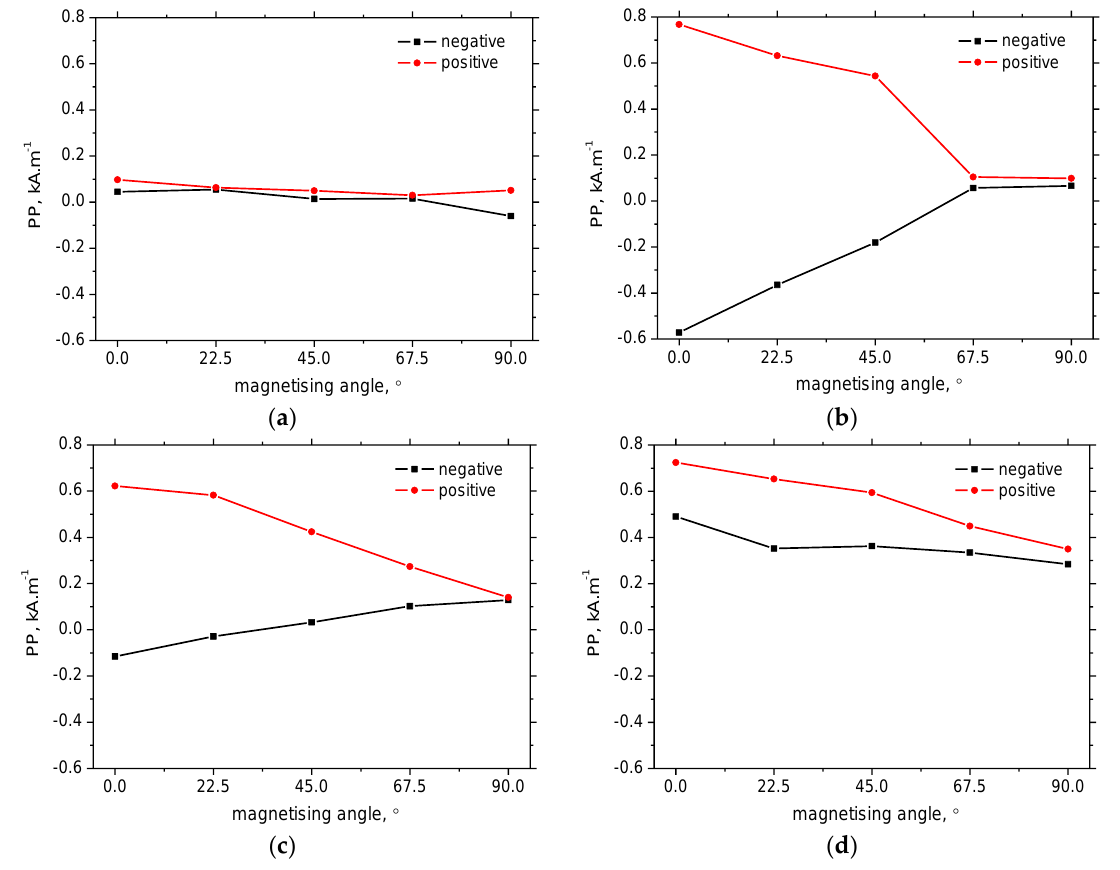
Figure 14. PP for the positive and negative bursts as a function of ε , 5V. ( a ) ε = 2.5%, ( b ) ε = 15%, ( c ) ε = 30%, ( d ) ε = 40%.